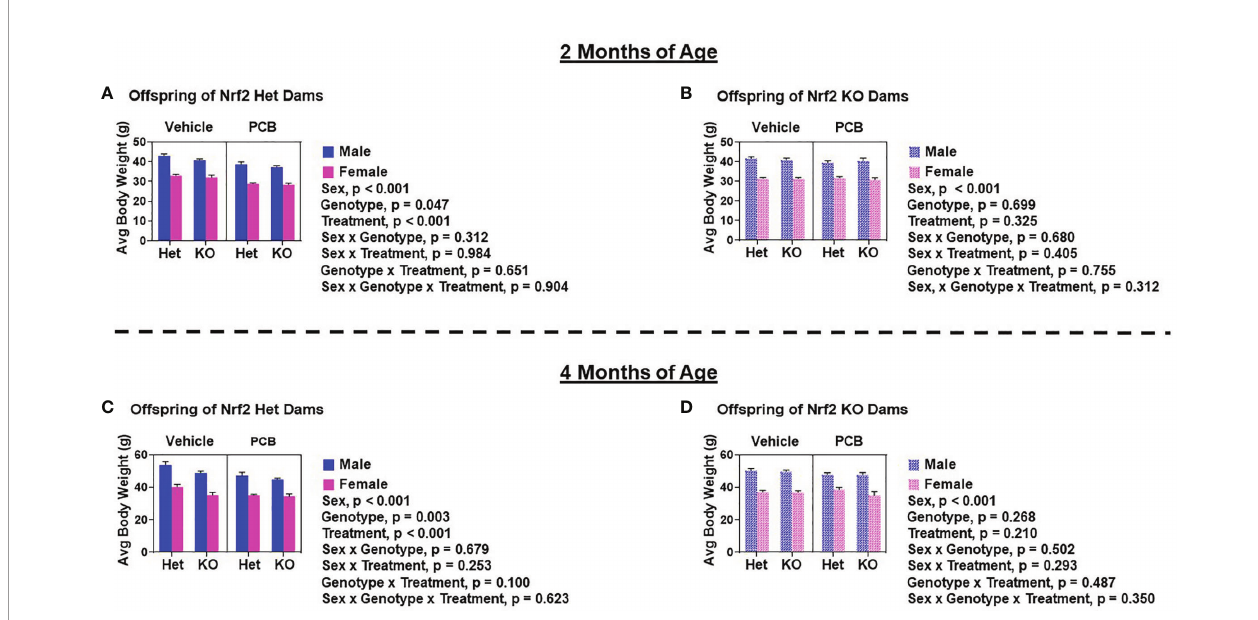
FIGURE 2 | Adult offspring born to Nrf2 heterozygous dams exposed to PCB126 during pregnancy are more sensitive to the adverse effects of PCB126 on body weight. Offspring body weight was recorded weekly. Displayed are the body weights of offspring at two and four months of age that were born to Nrf2 heterozygous (A, C) and knockout (B, D) dams exposed to PCB126 or vehicle during pregnancy. Average offspring body weight values are representative of the mean of litter means (n = 8 – 13 per group) ± SEM. Data were analyzed using three-factor ANOVA. Signi fi cance was set at a =